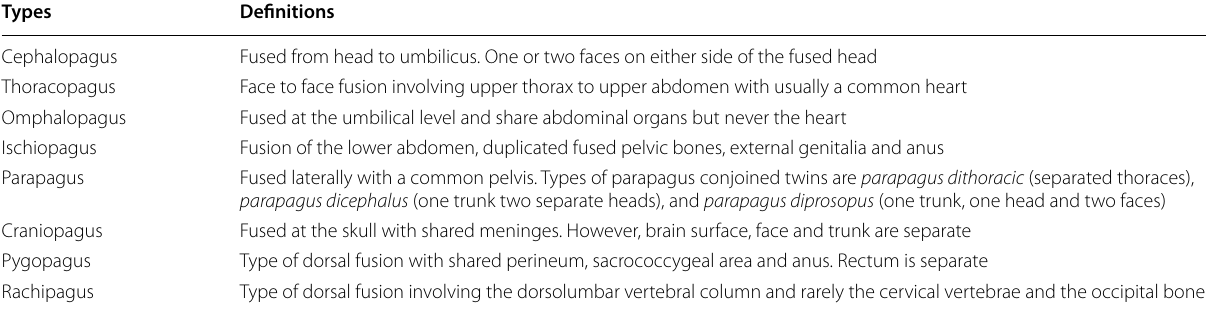
Table 1 Classification of conjoined twins according to the site of